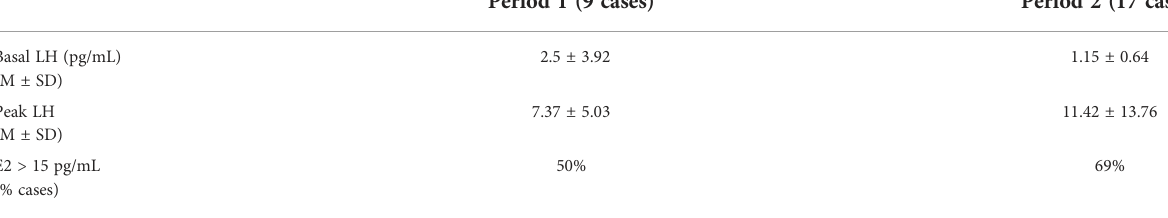
TABLE 3 Hormonal data at diagnosis in girls with CPP subdivided by observation period.